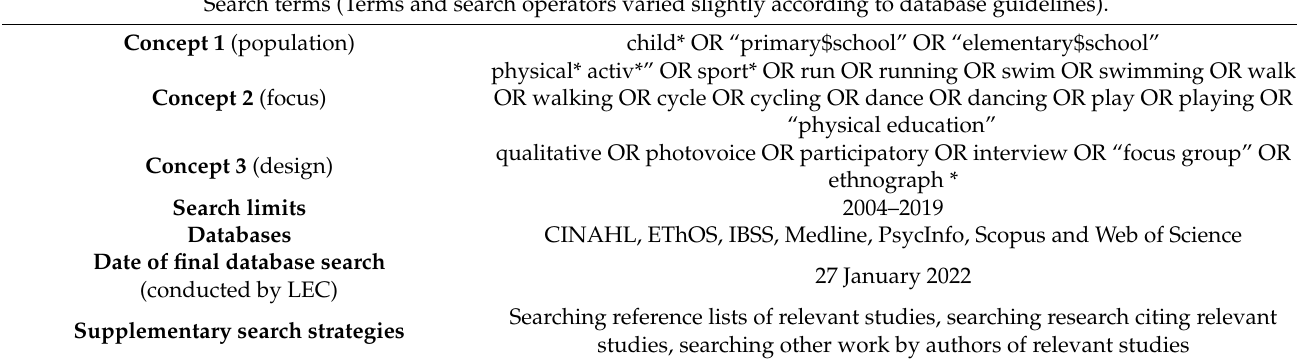
Table 1. Search strategy used to identify qualitative studies on children’s physical activity since 2004. Search terms (Terms and search operators varied slightly according to database